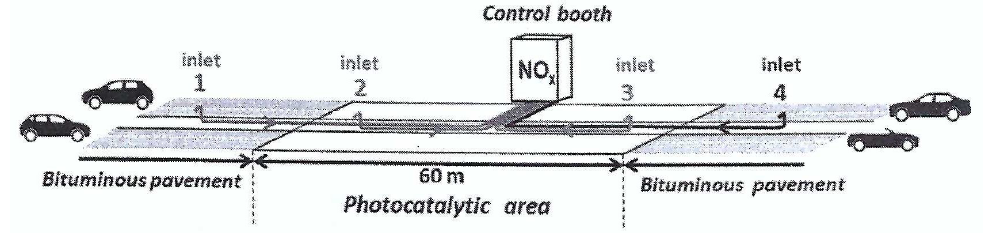
Figure 19. Illustration of the experimental setup for a real-scale test of a road surface coated with a photocatalyst for the removal of NO x . (Reprinted/adapted with permission from Ref.